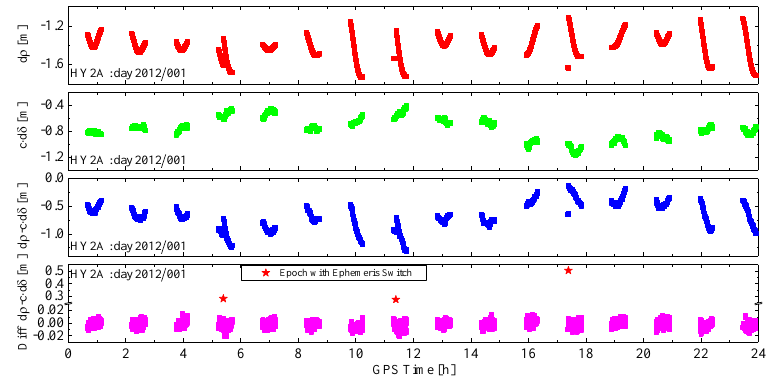
Figure 2. The LOS error and its inter-epoch difference of HY2A and GPS PRN04.